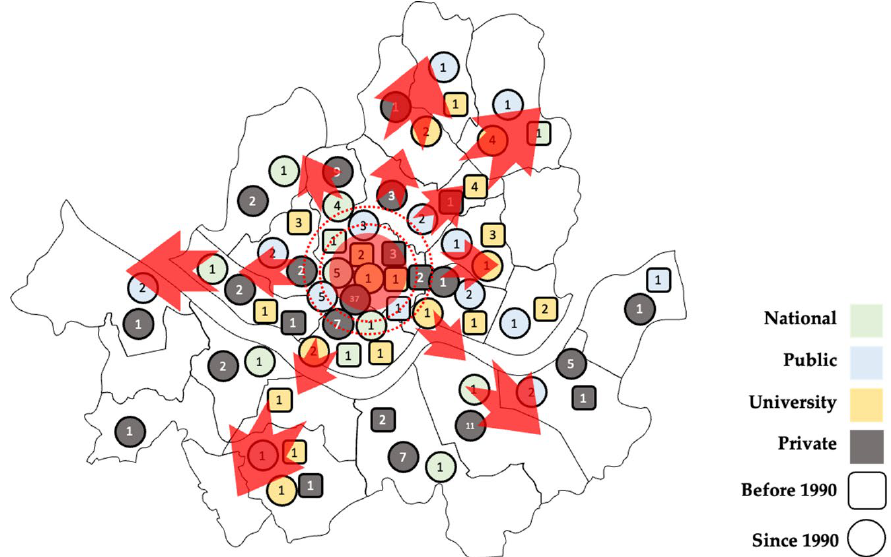
Figure 4. Distribution and expansion trends of museums before and after 1990.